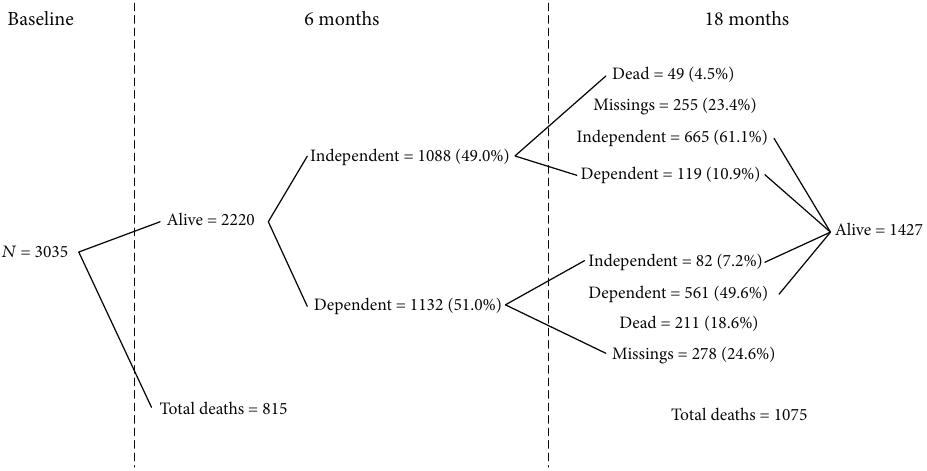
Figure 1: Baseline ( n = 3035 ), 6 months ( n = 3035 ), and 18 months ( n = 2502